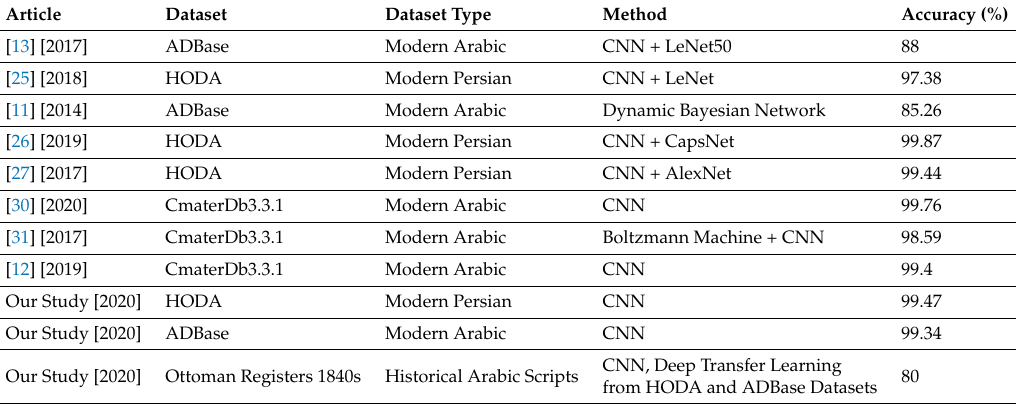
Table 1. The comparison of our study with the Arabic handwritten digit recognition studies on different datasets.